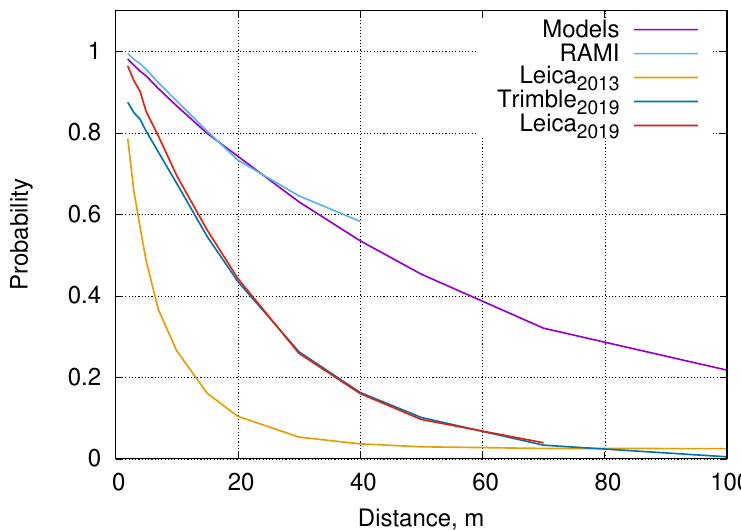
Figure 3. Birch stand: probability of free line of sight as computed from the generated tree pattern models, as computed from measured tree positions and measured stem diameters (RAMI database), and as estimated from the TLS point clouds generated by three different scanners in three different field sessions.